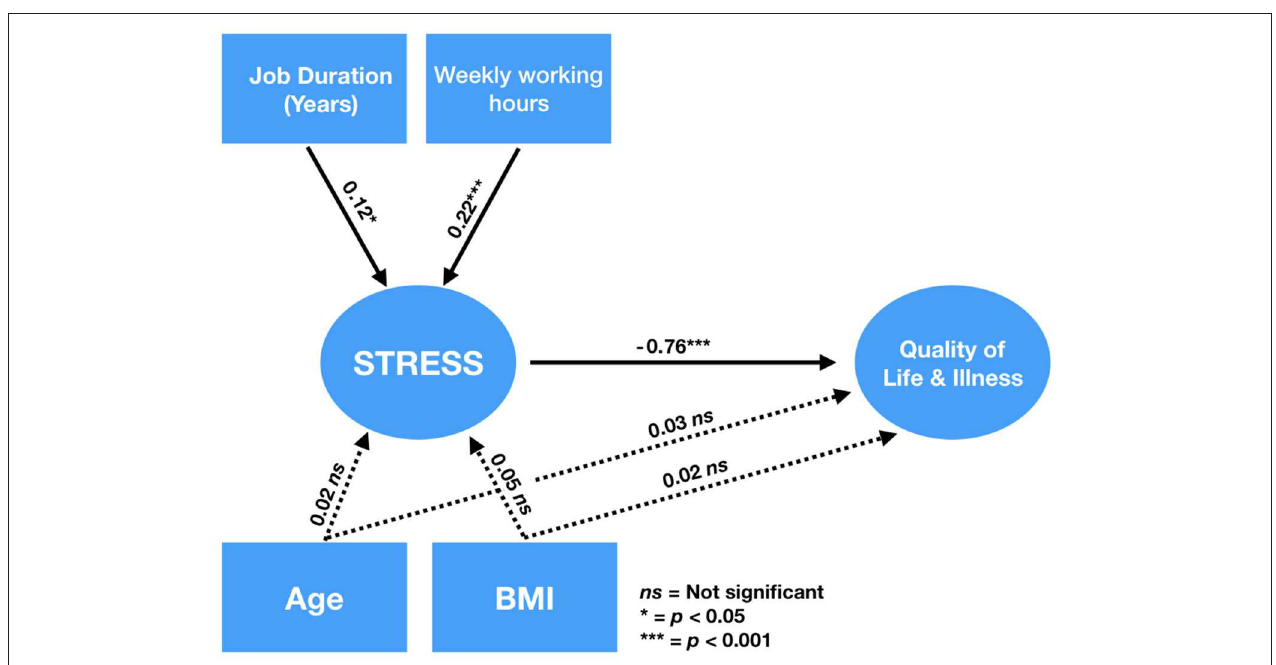
FIGURE 1 | SEM analyses. Full mediation model and standardized coefficients. Measurement model and lower-order latent variables were omitted in the figure to simplify the visualization. Dashed lines represent non-significant paths. Models used for model comparison and estimates for the winning model using SEM.